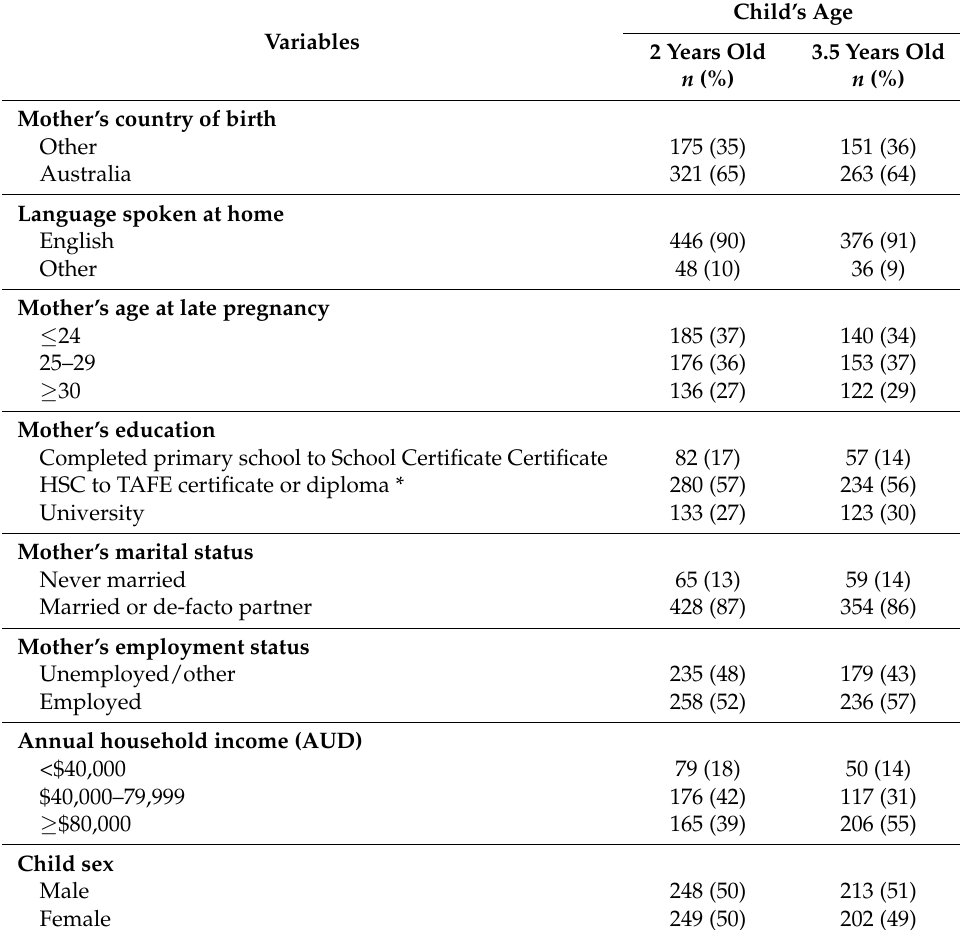
Table 1. Characteristics of participating mothers and children at ages 2 and 3.5